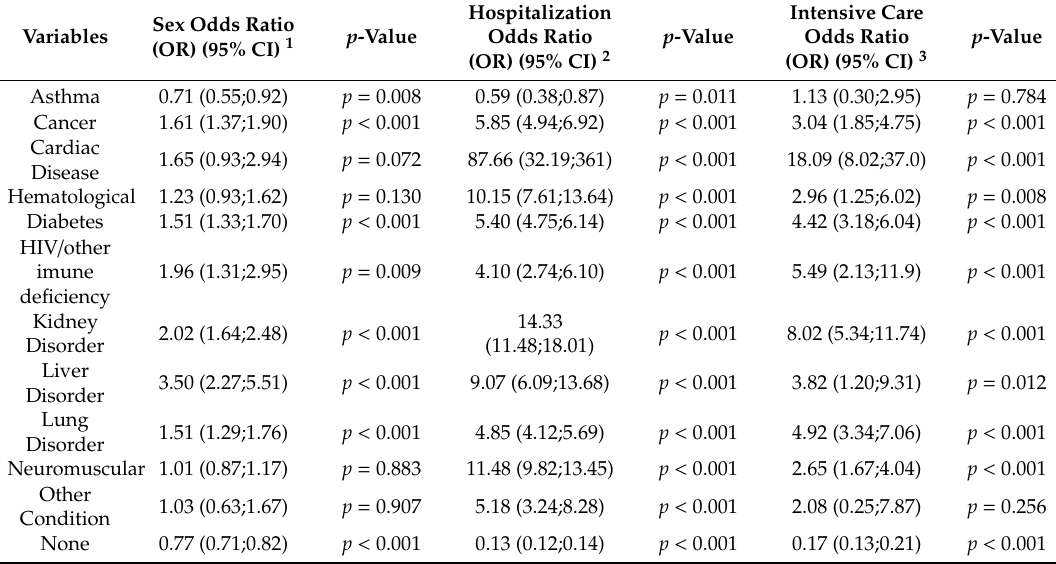
Table 2. Analysis for sex, hospitalization, and intensive care, according to the individuals’